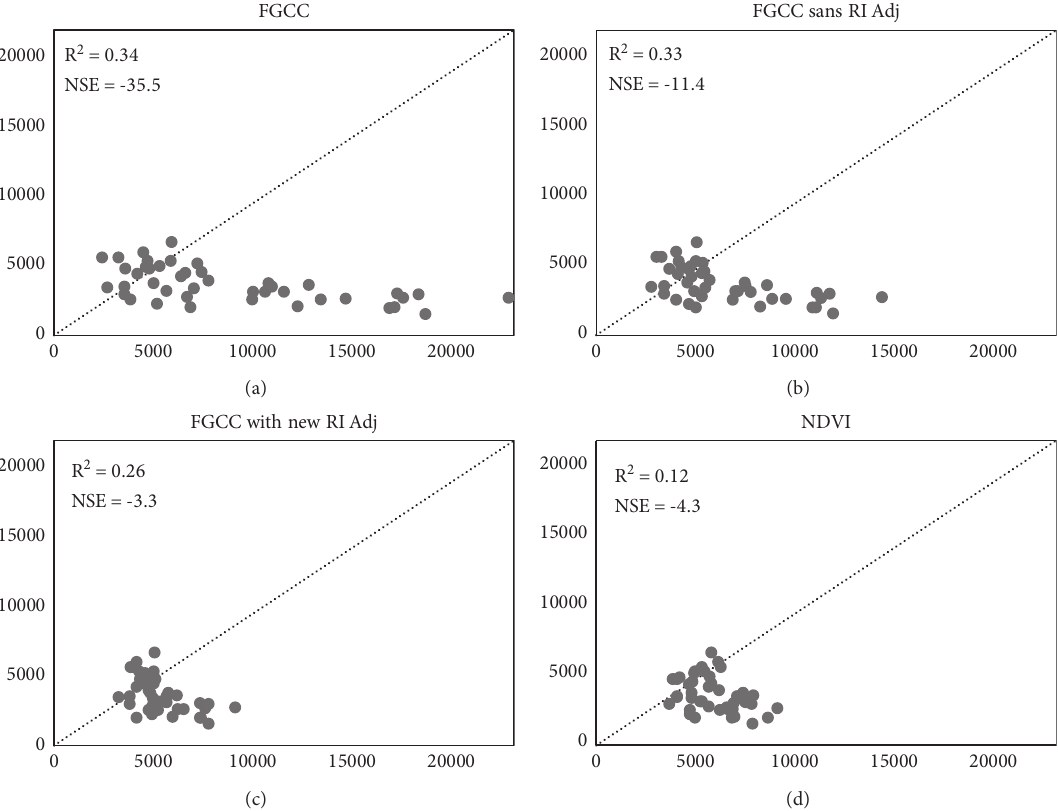
Figure 4: Model depicting the predicted yields using sensor readings plotted against actual yield. These points were developed from the FGCC readings (a), FGCC yield prediction without the RI adjustment (b), and FGCC with the new RI adjustment (c), and the NDVI from the same dataset (d). As expected, RI Sensor caused inaccuracies with yield prediction. Removing the RI adjustment pulled those values closer to 1 :1 but was still not enough to be considered accurate. Adjusting RI Sensor with the new RI adjustment caused those values to become similar in accuracy as the NDVI derived yield prediction, with a couple of outliers, coming from locations with very high RI Sensor